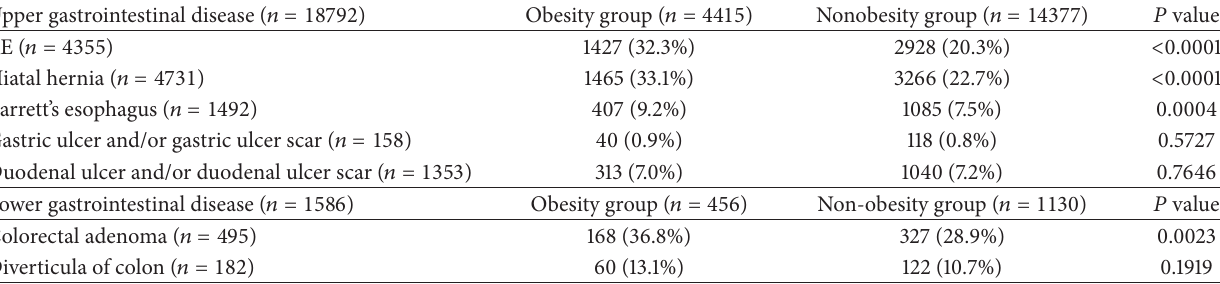
Table 1: Prevalence of gastrointestinal disease in obese versus non-obese groups.